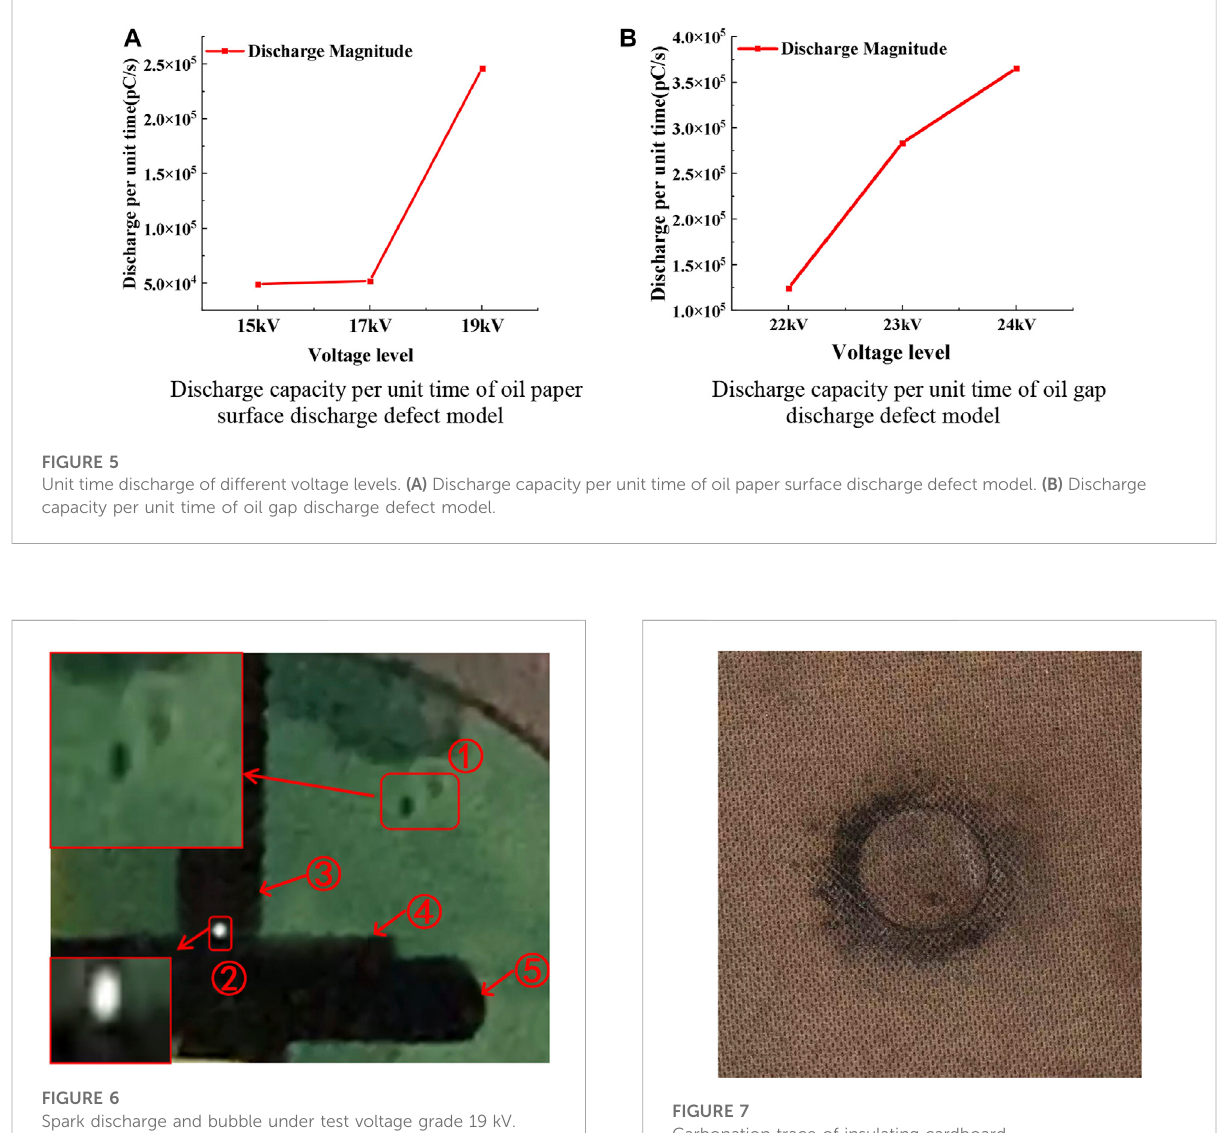
Carbonation trace of insulating